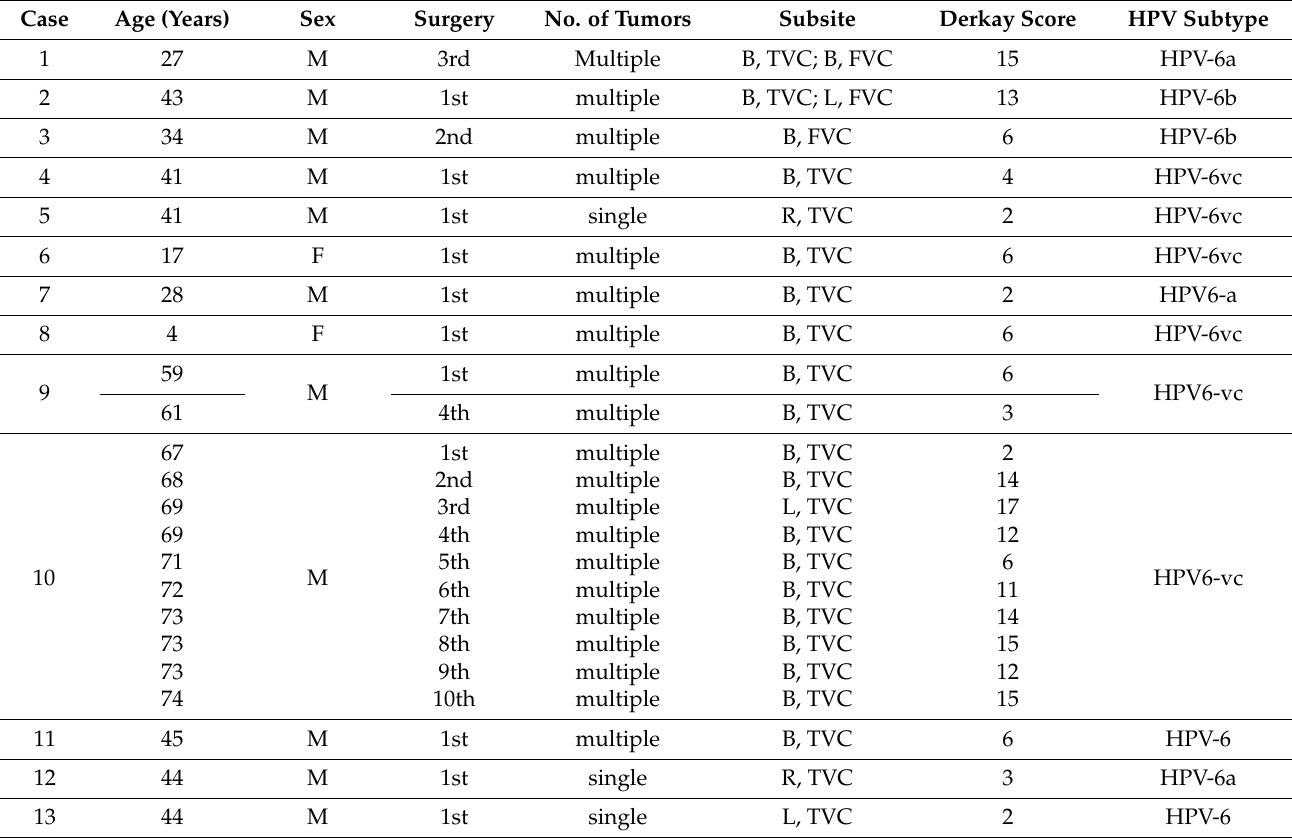
Table 1. Clinical profiles of 13 patients with HPV-6-infected laryngeal papilloma